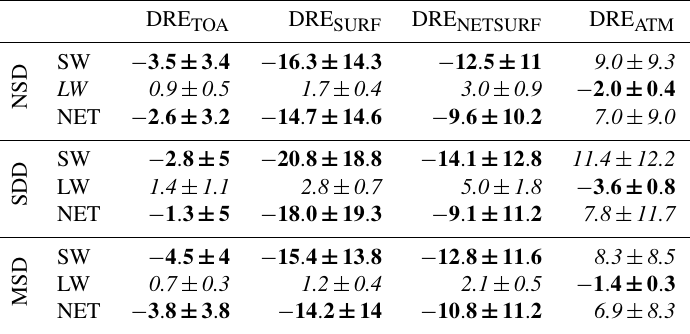
Table 2. Mean and standard deviation of all-sky DRE TOA , DRE SURF , DRE NETSURF and DRE ATM values, over the simulation period (84h), calculated in the NSD, SDD and MSD domains for the SW, LW and NET radiation. Bold and italic fonts indicate negative (cooling effect) and positive (warming effect) DREs,